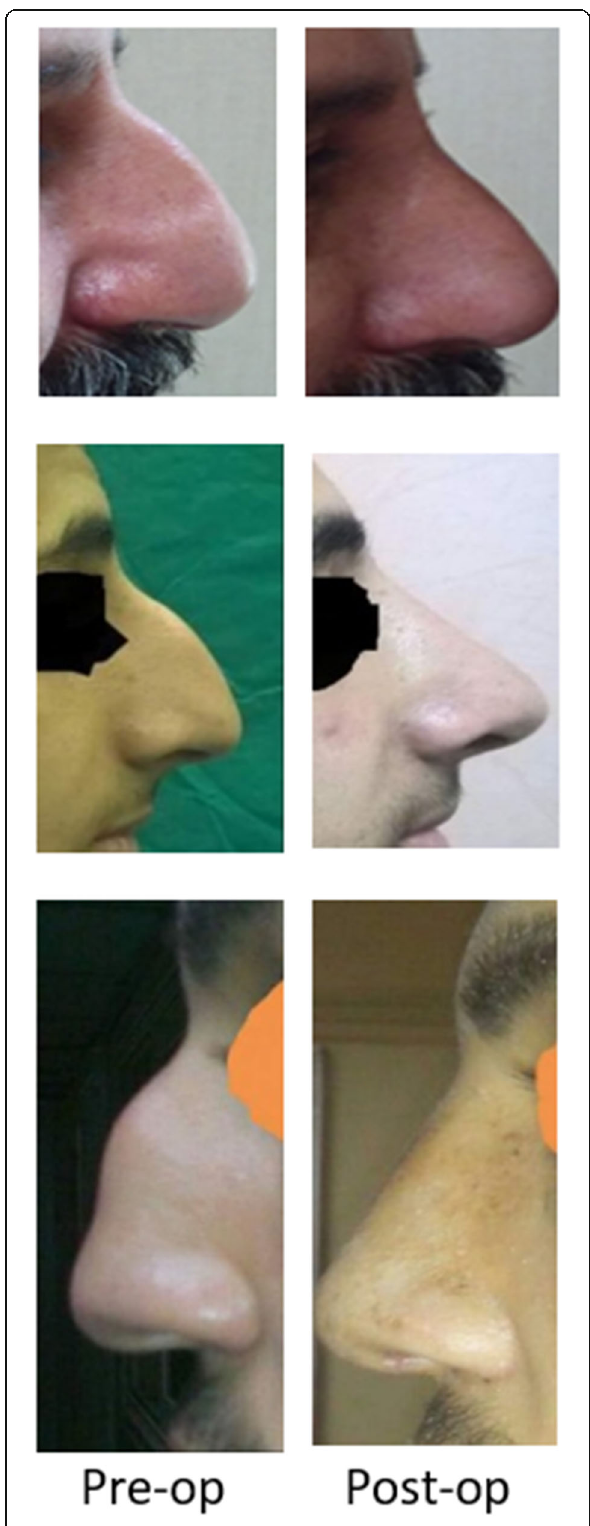
Fig. 2 Preoperative and postoperative photographs of patients who received modified perichondrial-periosteal